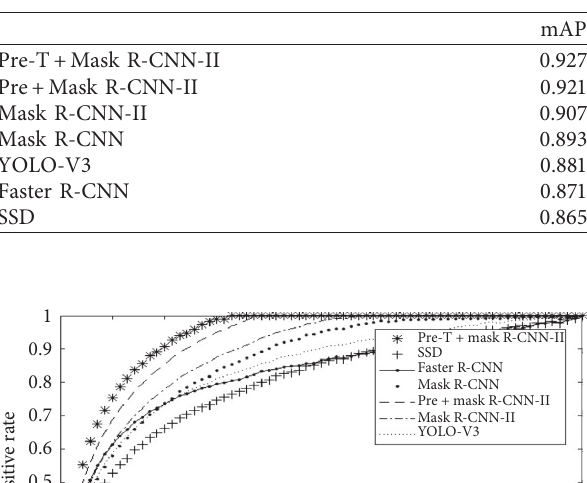
Table 2: Results of each model.